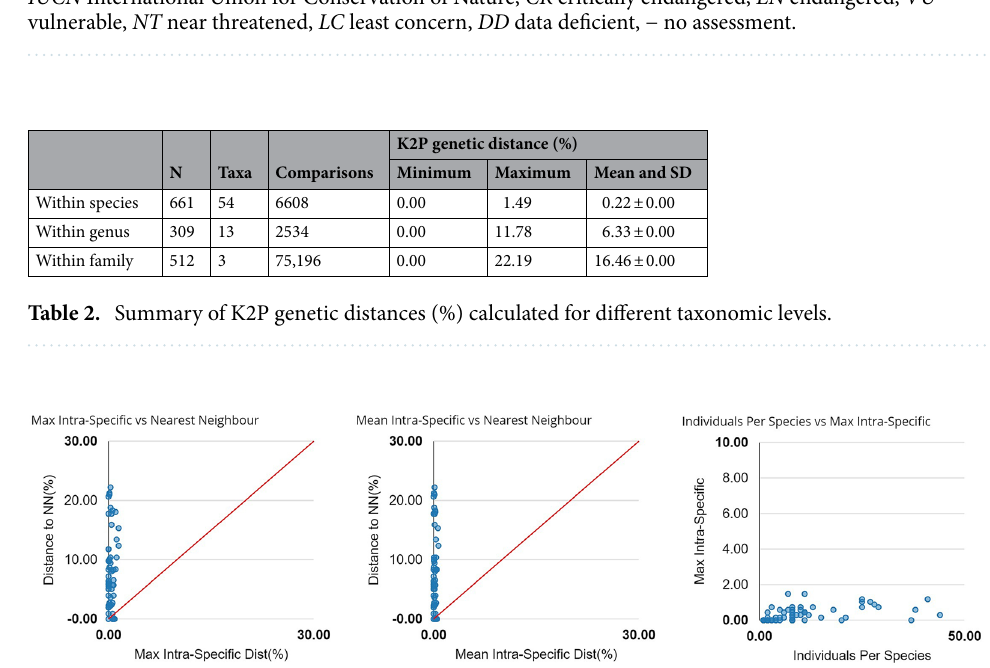
Figure 1. Barcoding gap: Maximum intraspecific Kimura 2-parameter (K2P) distances compared with the minimum interspecific K2P distances recorded in fish from Uzbekistan. The graphs show the overlap of the maximum and mean intra-specific distances with the inter-specific (NN = nearest neighbor)